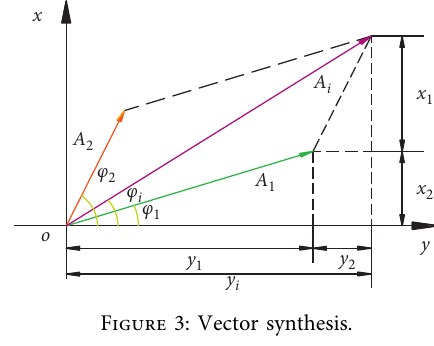
Figure 3: Vector synthesis.